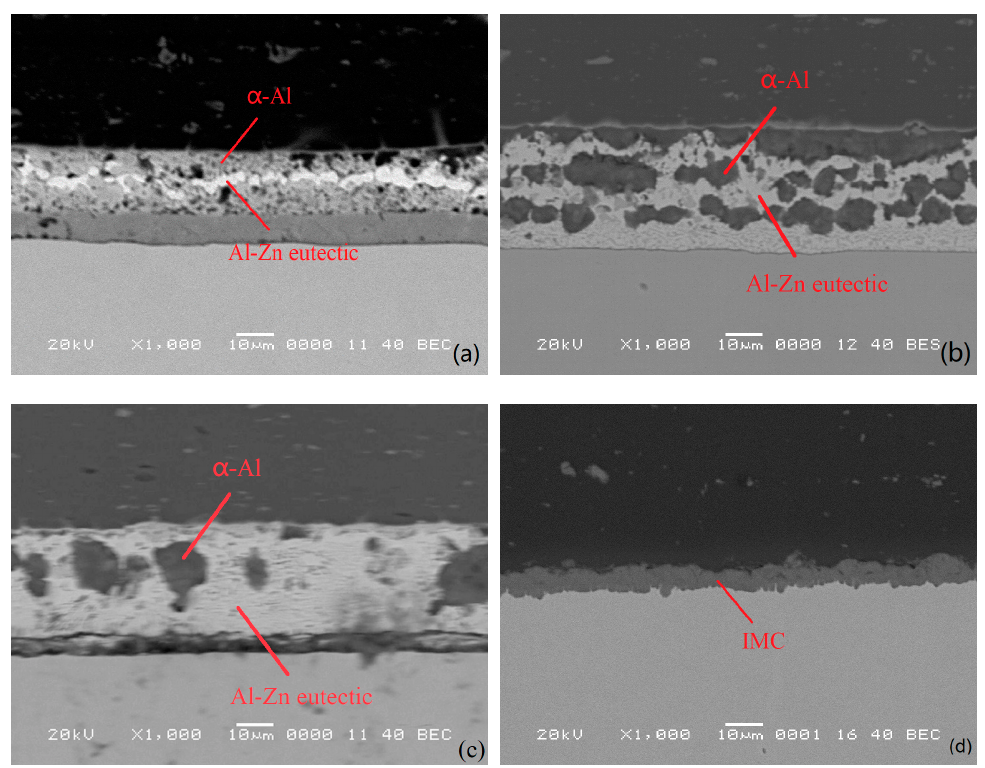
Table 6. Composition of intermetallic compounds (IMC).